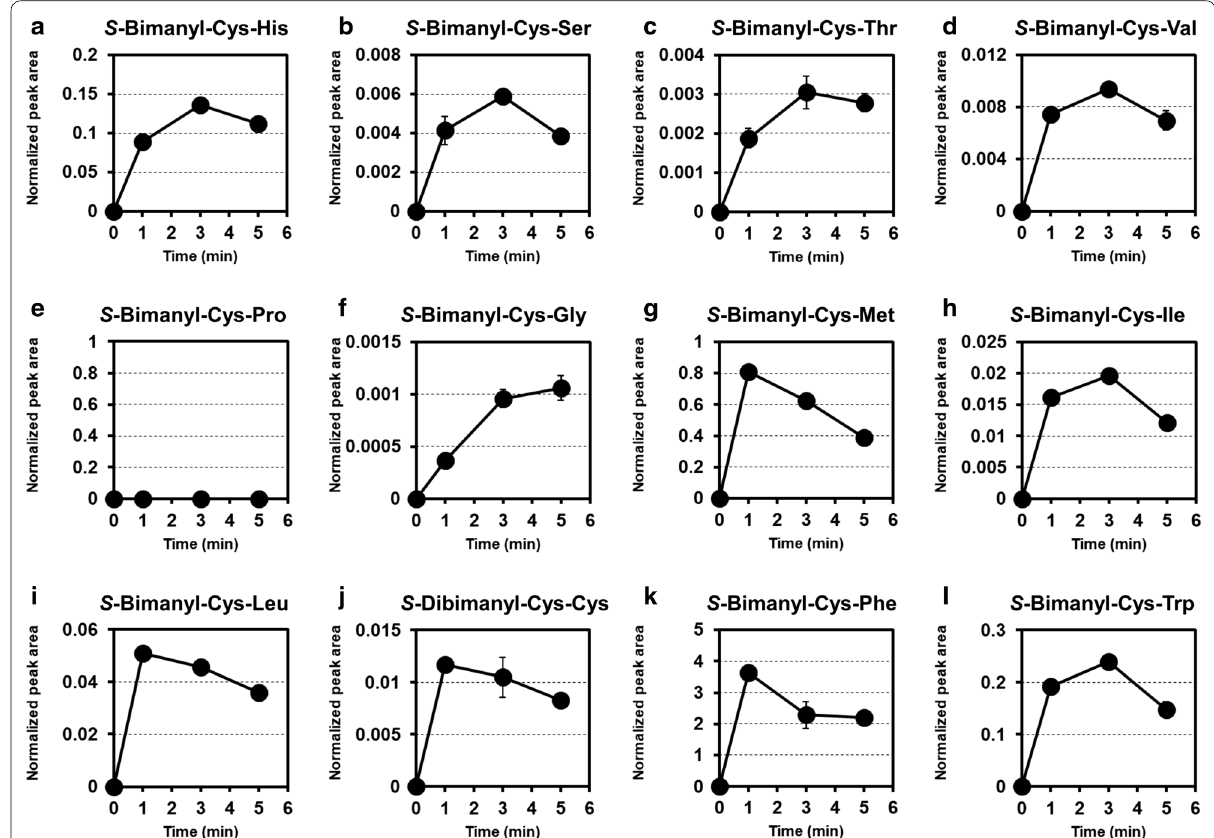
Fig. 4 Cysteine-containing dipeptide formation in the in vitro assays measured by the method of S -bimanyl derivatization developed in this study (Fig. 2). For the assays, supernatant of cell lysate from WT pQE85-BsBacD pCysHP was utilized, and the substrates were cysteine and a histidine, b serine, c threonine, d valine, e proline, f glycine, g methionine, h isoleucine, i leucine, j cysteine, k phenylalanine, or l tryptophan. Measured S -bimanyl dipeptides are indicated in the figures. The y-axis represents normalized peak area in the mass chromatogram monitoring m/z characteristic of individual target compounds, and x-axis represents reaction time of the assay; sampling time is 0, 1, 3, 5 min (see “Materials and methods”). Data values are mean SE (n ± =